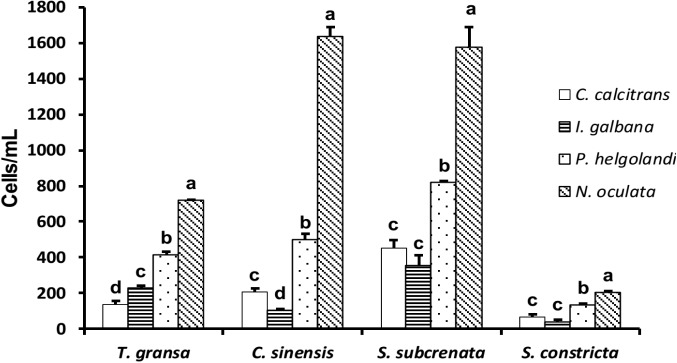
The concentration of each microalgal species (Chaetoceros calcitrans, Isochrysis galbana, Platymonas helgolandica and Nannochloropsis oculata) in biodeposits of Tegillarca gransa, Cyclina sinensis, Scapharca subcrenata and Sinonovacula constricta after 3 h of feeding.Values are expressed as the means ± SD (n = 3). Differences between algal species per bivalve species were evaluated by one-way ANOVA, followed by the Duncan’s multiple range test. Labeled means without a common letter differ, P<0.05.